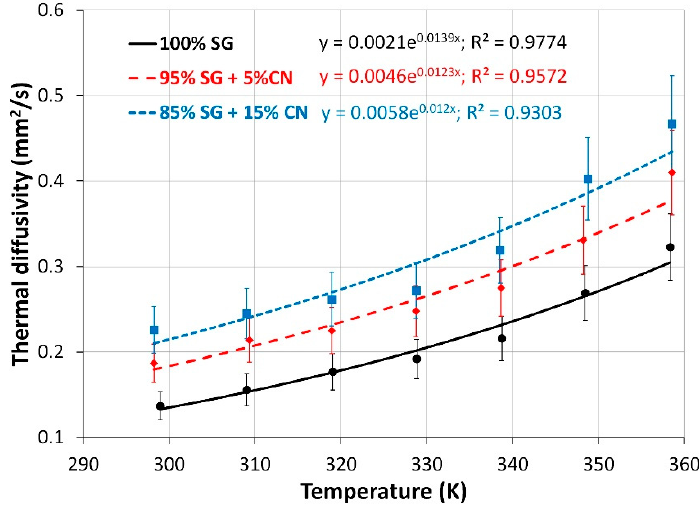
Figure 6. Effect of CNT additives on the thermal diffusivity of the SG-based adsorption bed.